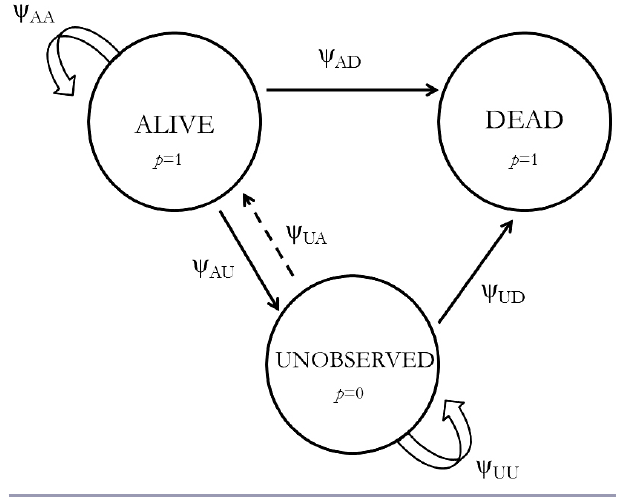
Fig. 1 . Diagram illustrating the multistate mark-recapture model used to analyze Mountain Plover ( Charadrius montanus ) chick survival for males and females. Data were collected in eastern Colorado from 2010 to 2012. Multistate parameters include: transition ( ψ ij; i = state at time t, j = state at time t + 1) probabilities between states and detection probabilities (p) while in states. Transition probabilities are based on the probability of a chick moving or remaining in a state on a daily basis. Three states are defined: alive (A), dead (D), and unobserved